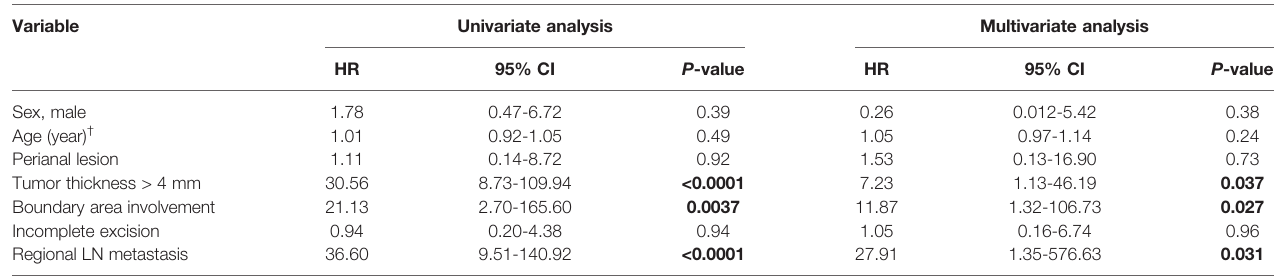
TABLE 4 | Multivariate Cox proportional hazard analyses for disease-speci fi c